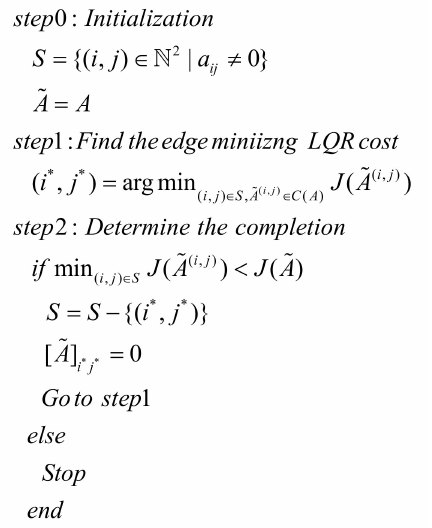
Figure 3. Sequential edge removal algorithm.